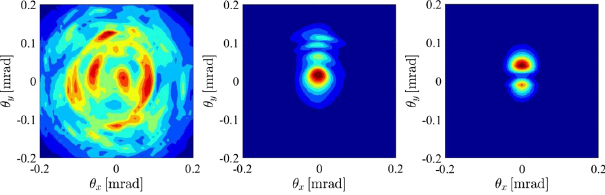
focusing.FIG. 6. Transverse mode pattern around 3.9 nm of normal SASE FELs (left), for using natural transverse gradient without external focusing (middle), and for NTG with external focusing